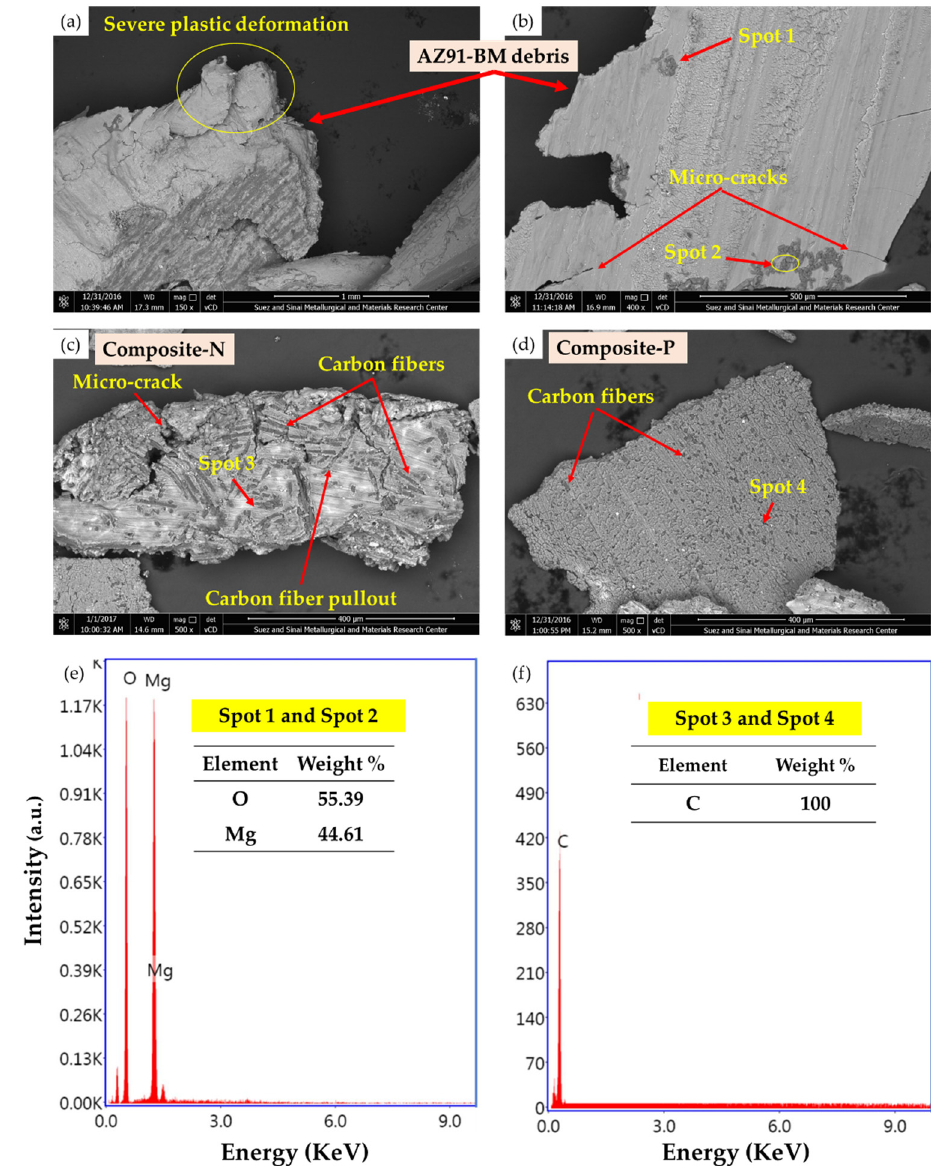
Figure 9. SEM images of the debris of the wear-tested specimens, where ( a , b ) AZ91-BM, ( c ) Composite-N ( d ) Composite-P, ( e ) EDS spot analysis of MgO, and ( f ) EDS spot analysis of Carbon fiber.